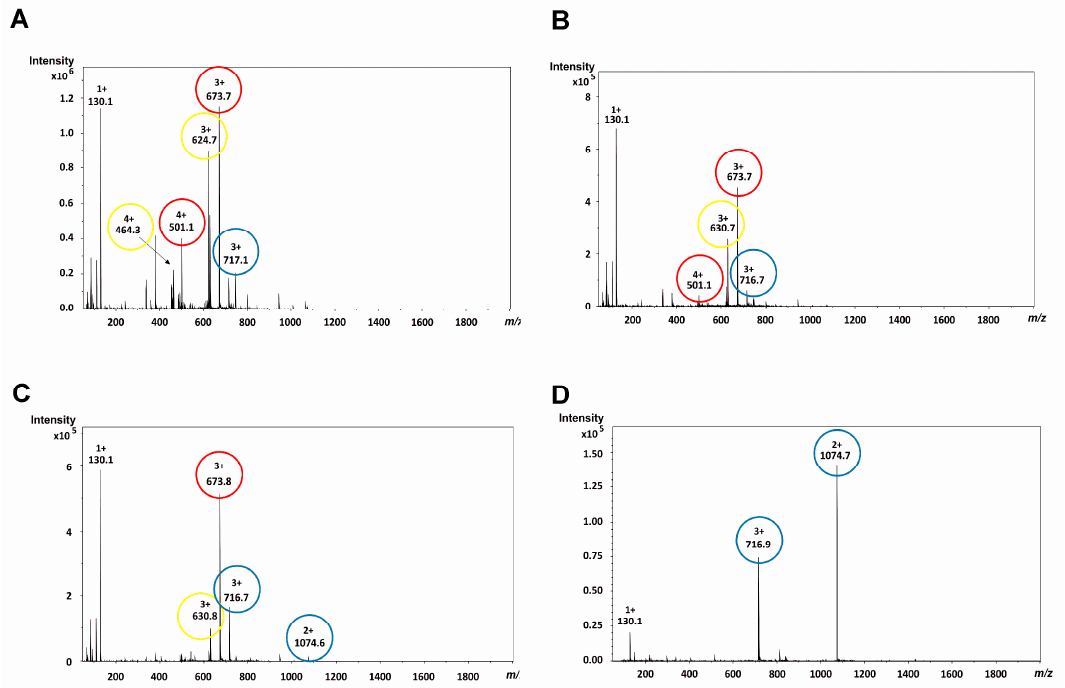
Figure 3. ESI-MS spectra of conjugate 4 ( A ) under the commonly used ion source parameters (136 V capillary exit potential); ( B ) using reduced capillary exit potential (5 V); ( C ) in non-acidic solvent mixture (acetonitrile-water 50:50% v / v ; 5 V capillary exit potential); ( D ) measured in 50 mM NH 4 OAc buffer (pH = 6.7, diluted with acetonitrile 50:50% v / v ; 5 V capillary exit potential). Blue circles are used to label intact protonated molecules, yellow and red circles label protonated fragment ions with one and two sugar losses, respectively. Charge states and m / z values of the protonated molecules are shown in the Figure.